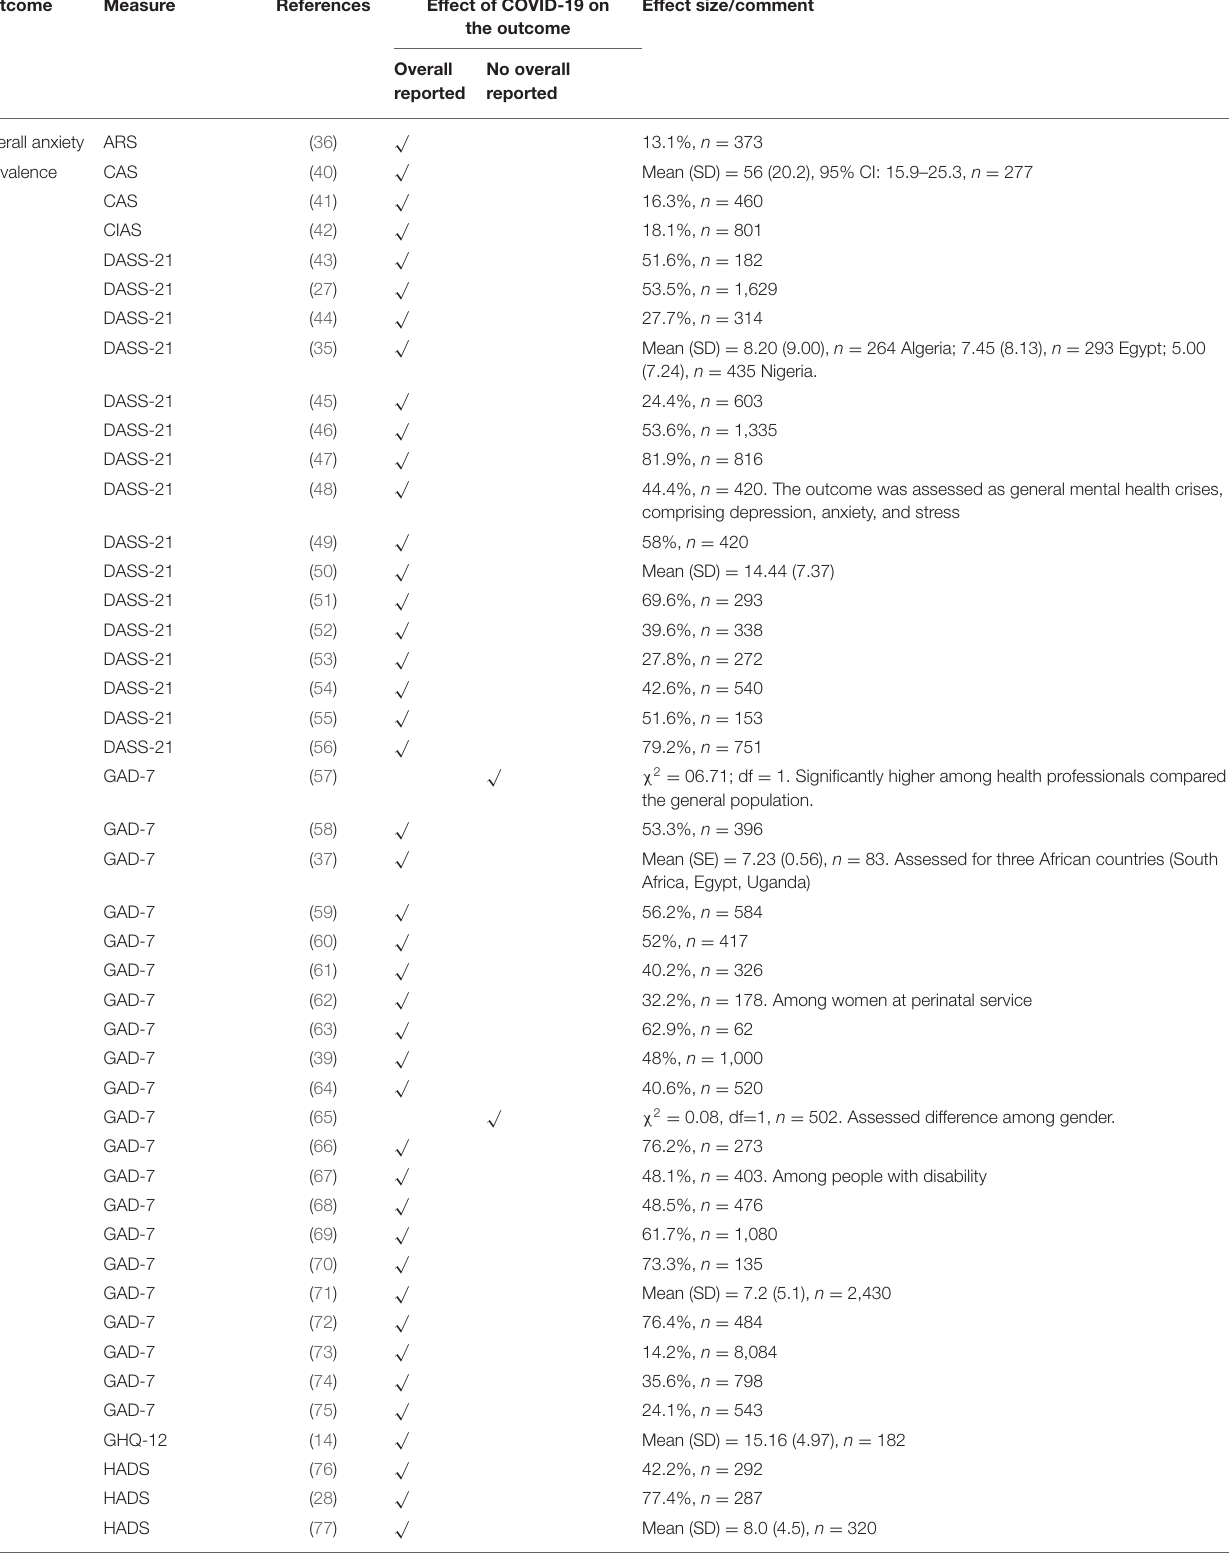
TABLE 1 | Anxiety-related COVID-19 effect in Africa.